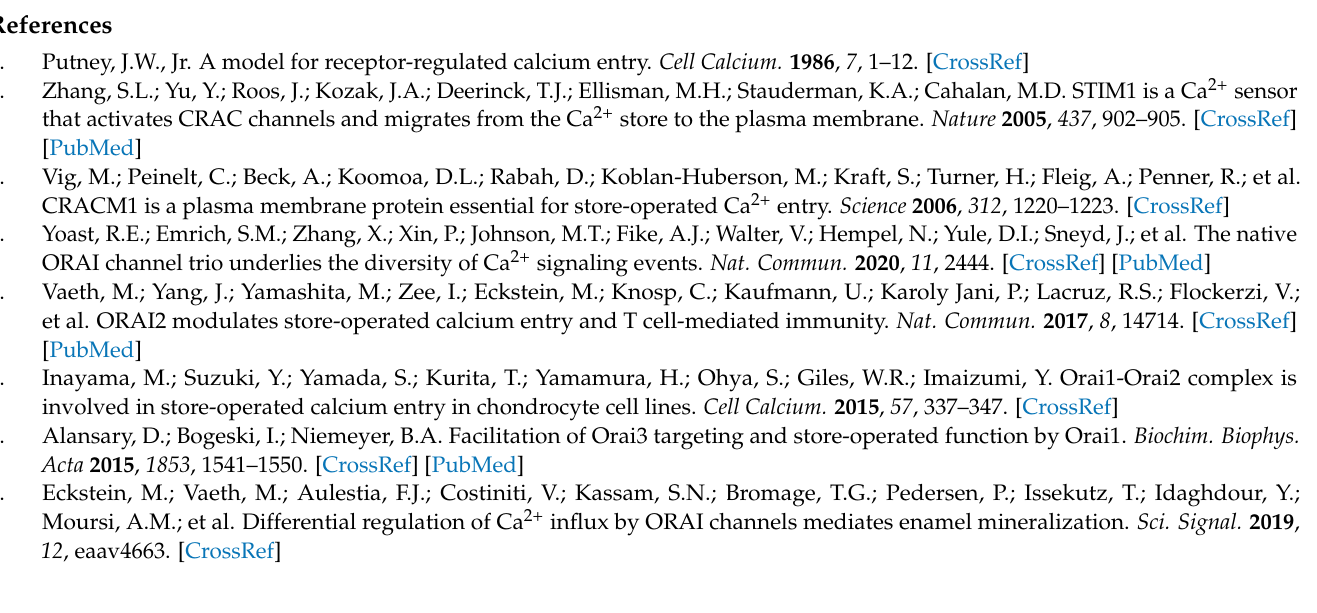
knockdown on Orai2 surface expression in T47D, SKBR3 and BT20 breast cancer cells. Figure S3: Effect of Orai2 knockdown on the expression of STIM1, STIM2, Orai1 and Orai3 in T47D, SKBR3 and BT20 breast cancer cells. Figure S4: Orai2 knockdown modifies NFAT1 transcriptional activity. Figure S5: Orai2 knockdown modifies NFAT4 nuclear translocation. Figure S6: Histogram of DNA content (propidium iodide, PI) versus number of cell counts (cell number), obtained by flow cytometry. Figure S7: Uncropped Western blots of Figure 1a,b and Figure 2a,f,k, Figures S2 and S3, Table S1: Total number of cells analyzed in Figure